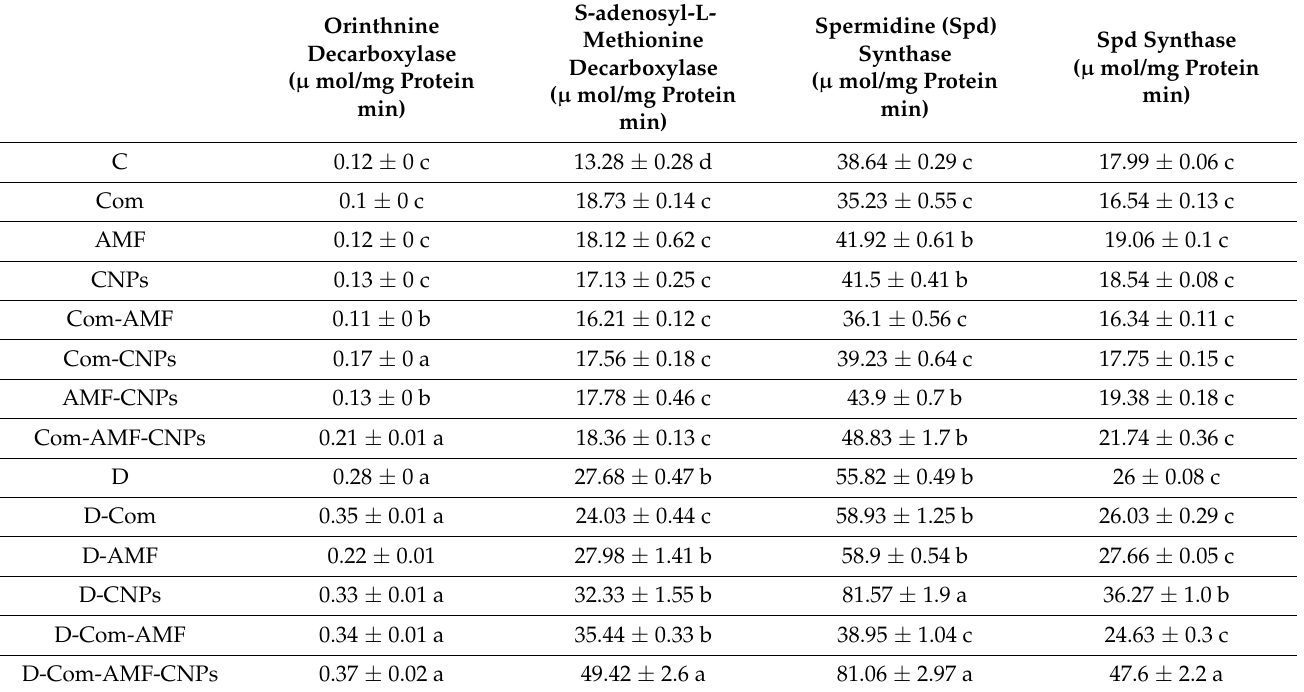
Table 6. Effect of different treatments on polyamine-related enzymes of maize under control and drought (D) conditions. Different letters indicate statistically significant difference between means for the different treatments at significance level of at least p ≤